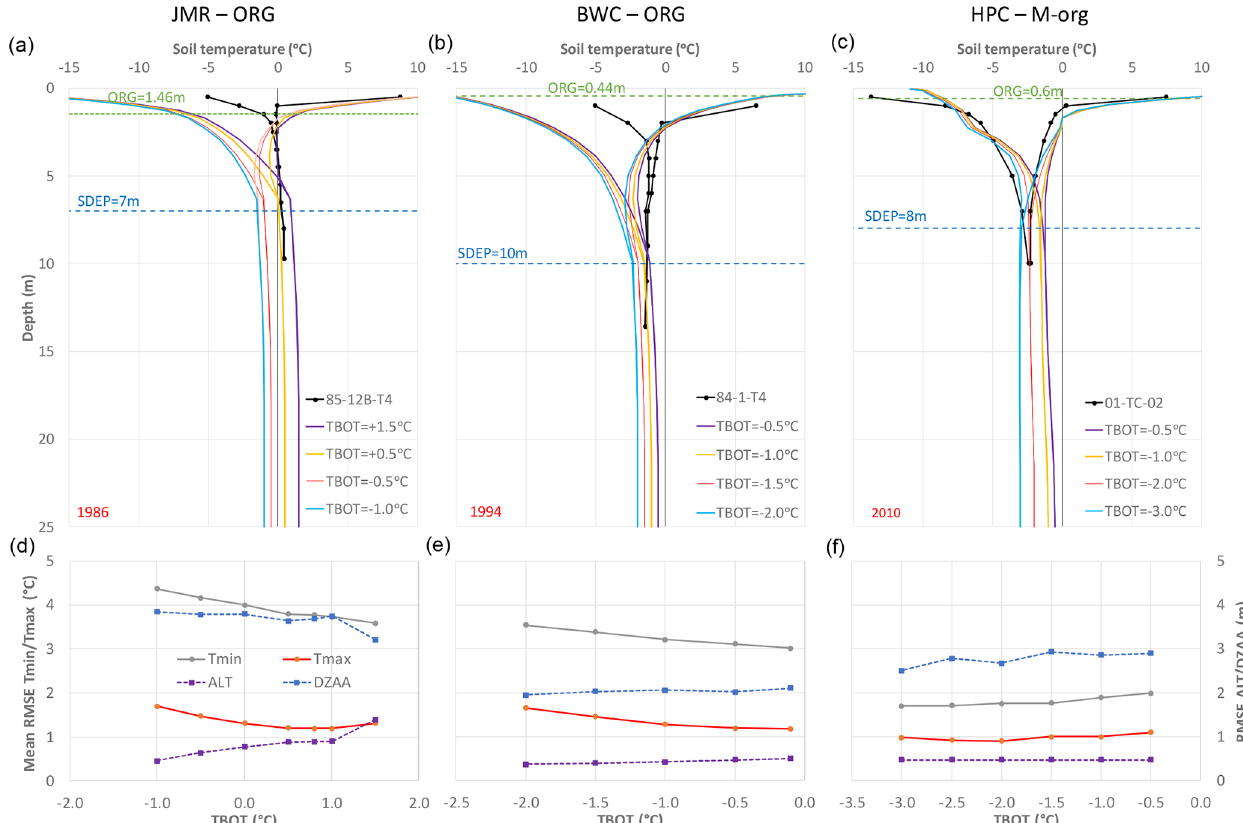
Figure 15. Impact of TBOT on simulated temperature envelopes for a selected year at each study site (a–c) . RMSE for temperature envelopes (Tmax and Tmin), ALT and DZAA (d–f) over the simulation period for the needleleaf forest GRU at each study